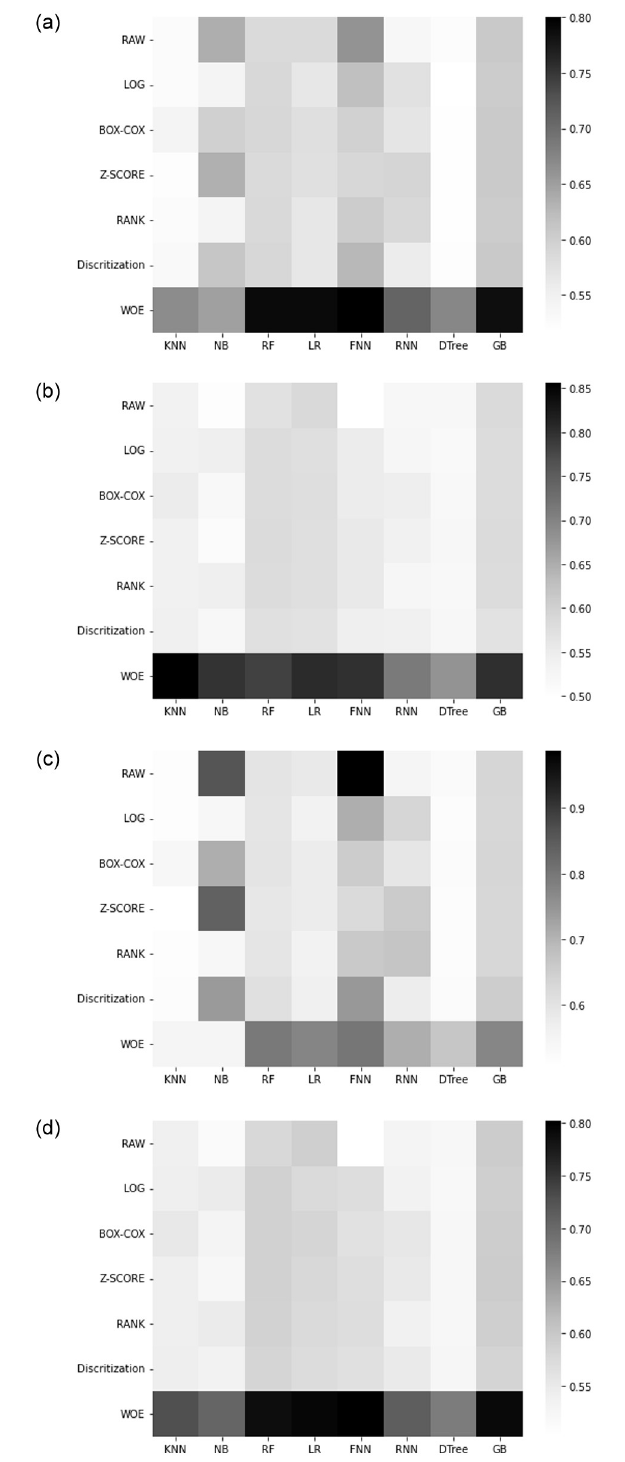
Fig 3. Performance comparison among the CCP methods using Dataset-1. (a) F-Measure. (b) Precision. (c) Recall. (d) AUC.